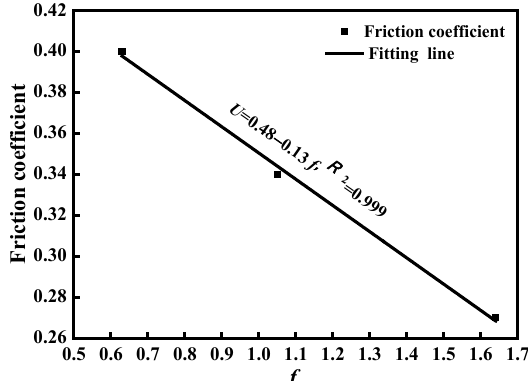
Figure 5. Relationship between friction coefficient and f value.